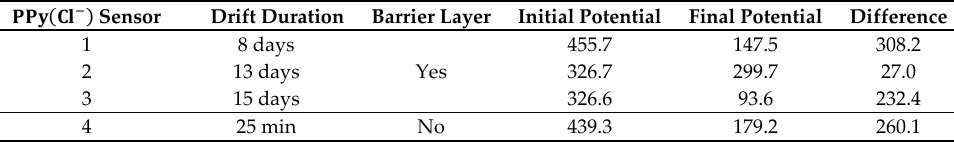
Table 4. Drift test